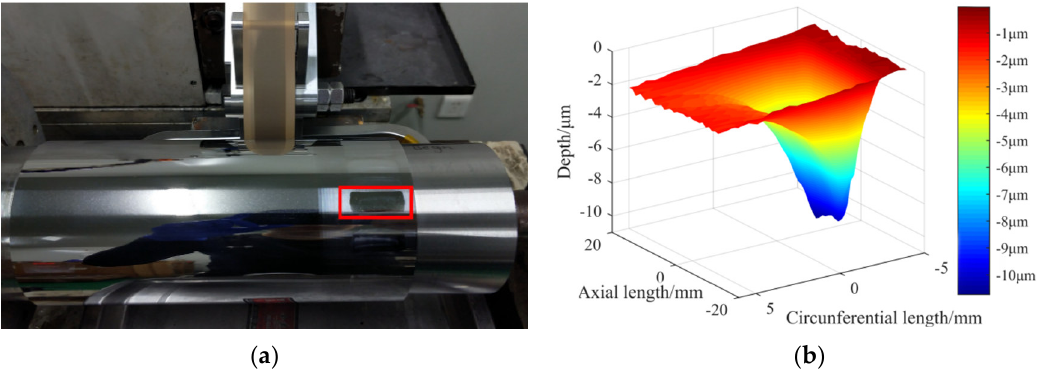
Figure 2. The removal function of deterministic grinding with a vibration-assisted abrasive belt: ( a ) actual appearance; ( b ) the extracted three-dimensional morphology.